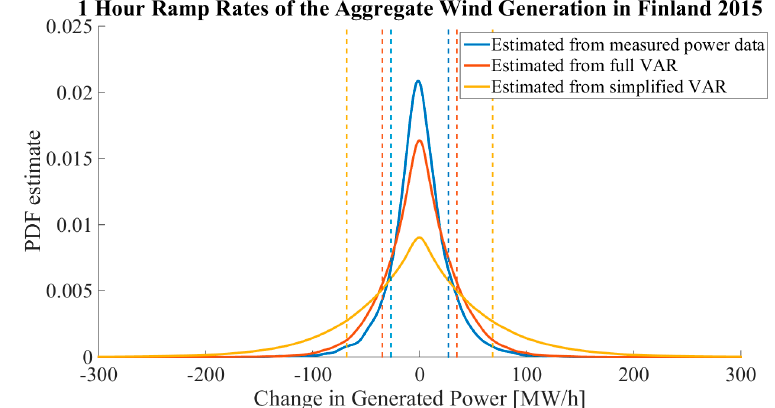
Figure 10. The one-hour ramp rate PDFs estimated from the measured aggregated wind power generation in Finland in 2015 and from the aggregated simulated data from the two models. The dotted lines illustrate the standard deviations of the one-hour ramp rates in the four cases with the corresponding colors. The presented simulation results are averages of the 100 MC runs.